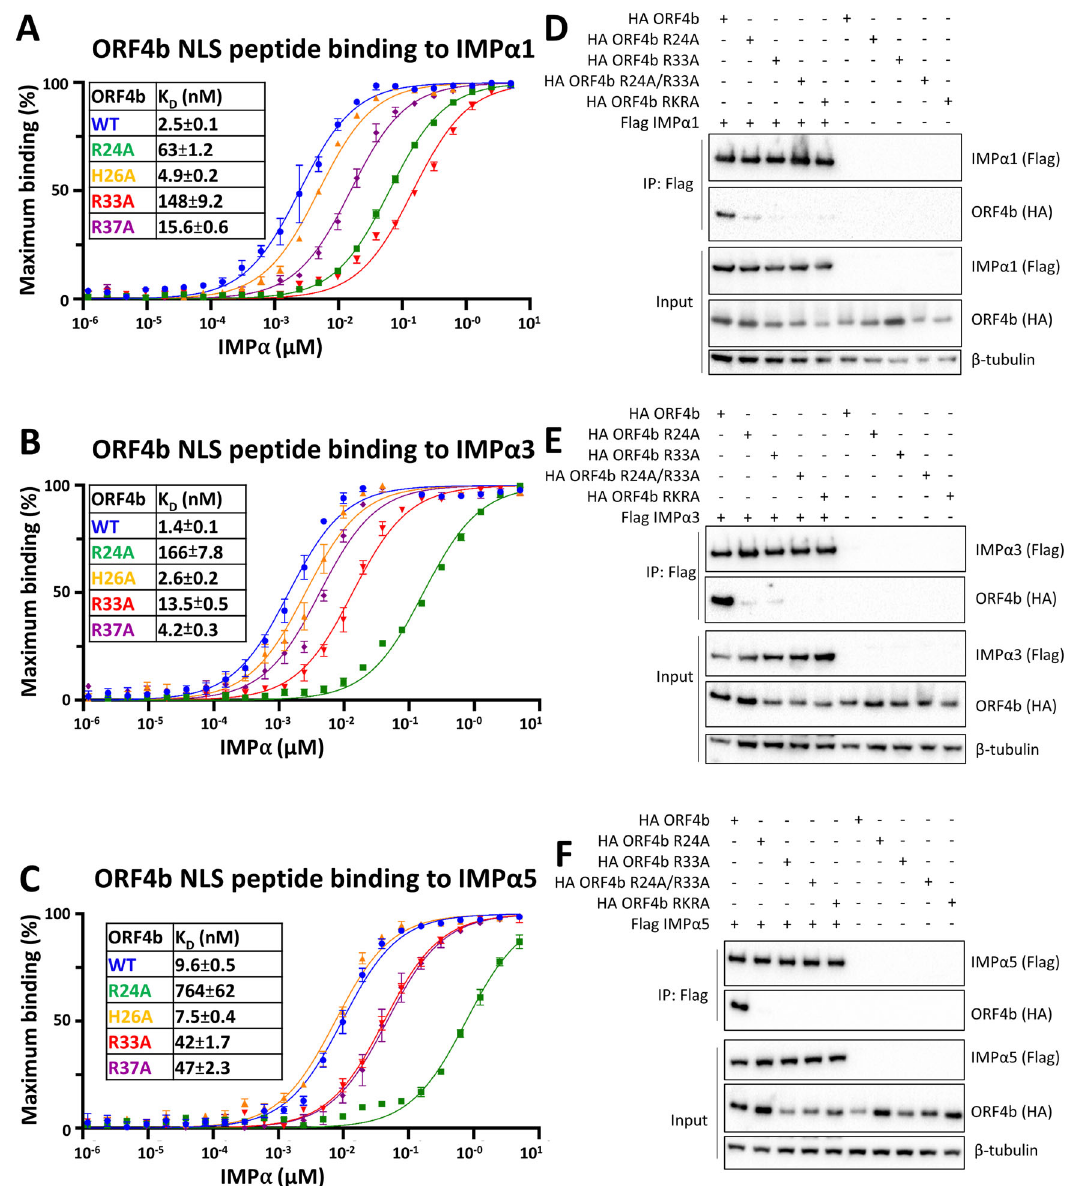
Fig. 4 Mutations within key binding determinants at the MERS ORF4b binding interface alter binding ef fi ciency to IMP α subfamilies.